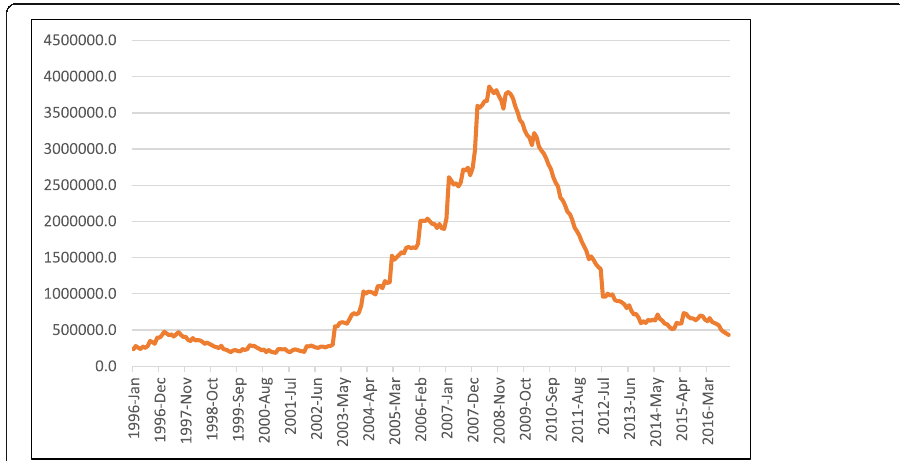
Fig. 2 General Cargo Ordered (total DWT*). * The DWT here accounts only the ships carrying DRY CARGO (oil, gas, chemicals or containers are not included). Source: the authors based on Clarkson